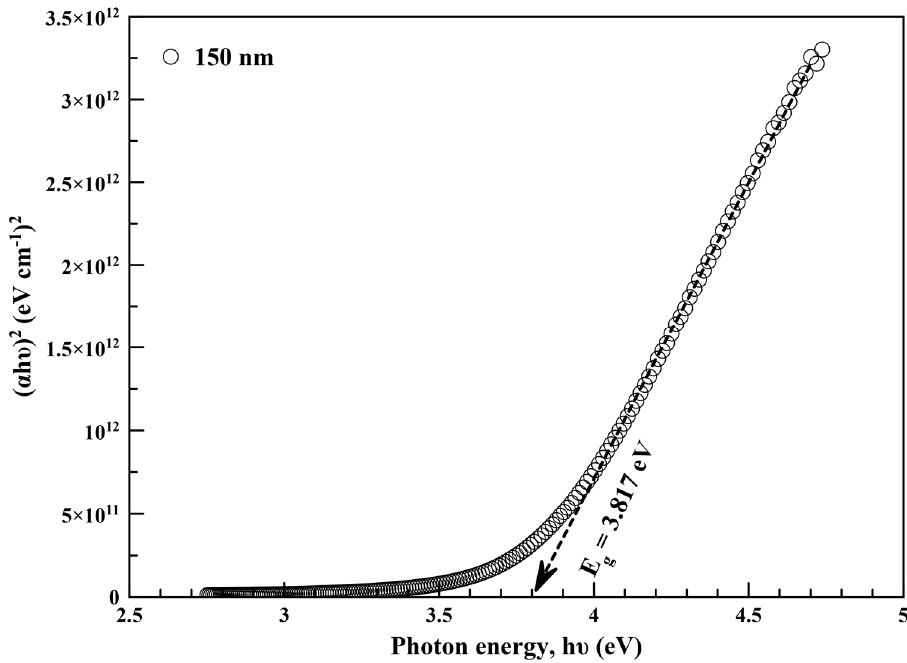
Figure 5. Optical band gap determination of 150 nm NiO x thin film.